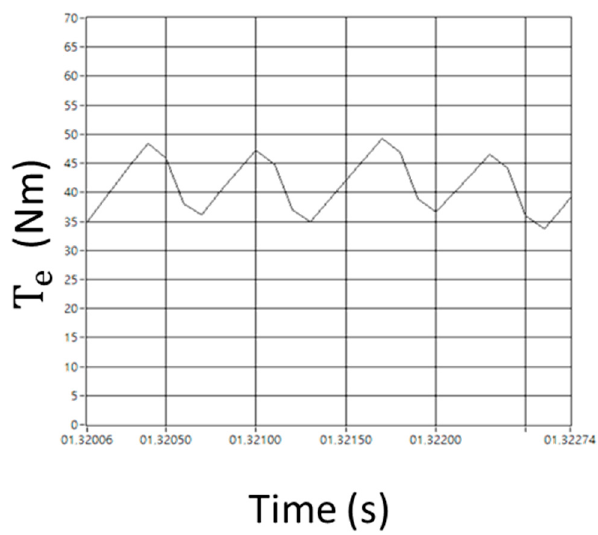
Figure 24. Electromagnetic torque of HIL test for proposed rSVM-DTC. Note that this figure was generated by the HIL directly, where on the horizontal axis, the number is from 1.32006 to 1.32274. This indicates that torque was recorded during the period between 1.32006 s and 1.32274 s.